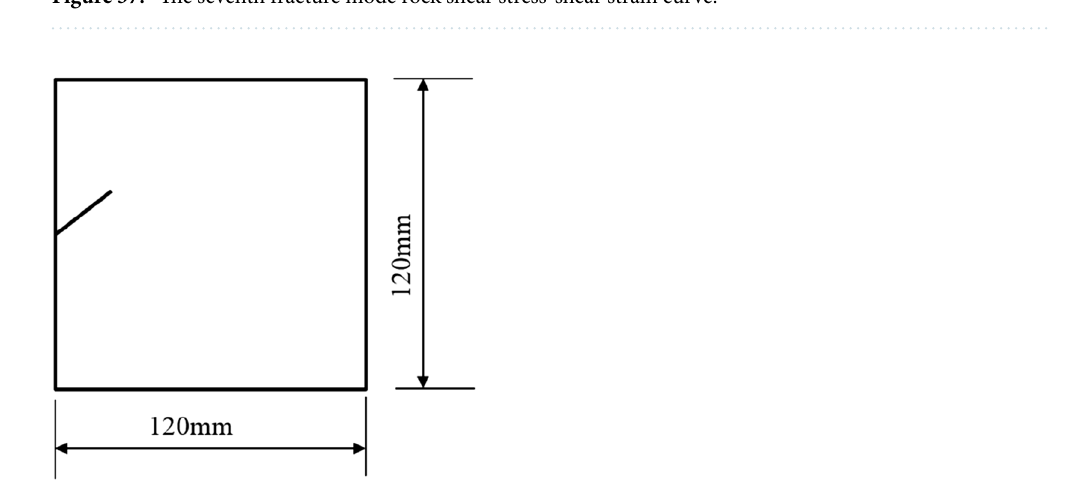
Figure 37. The seventh fracture mode rock shear stress-shear strain curve.